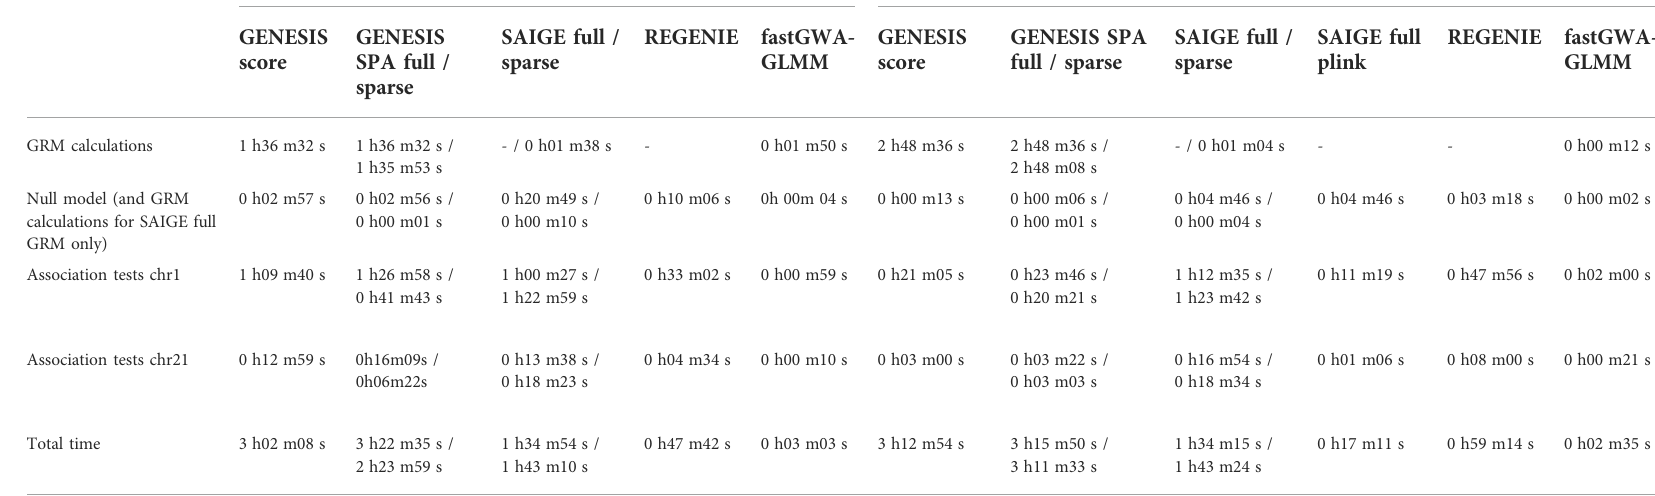
TABLE 4 Computation time used by GENESIS, SAIGE and